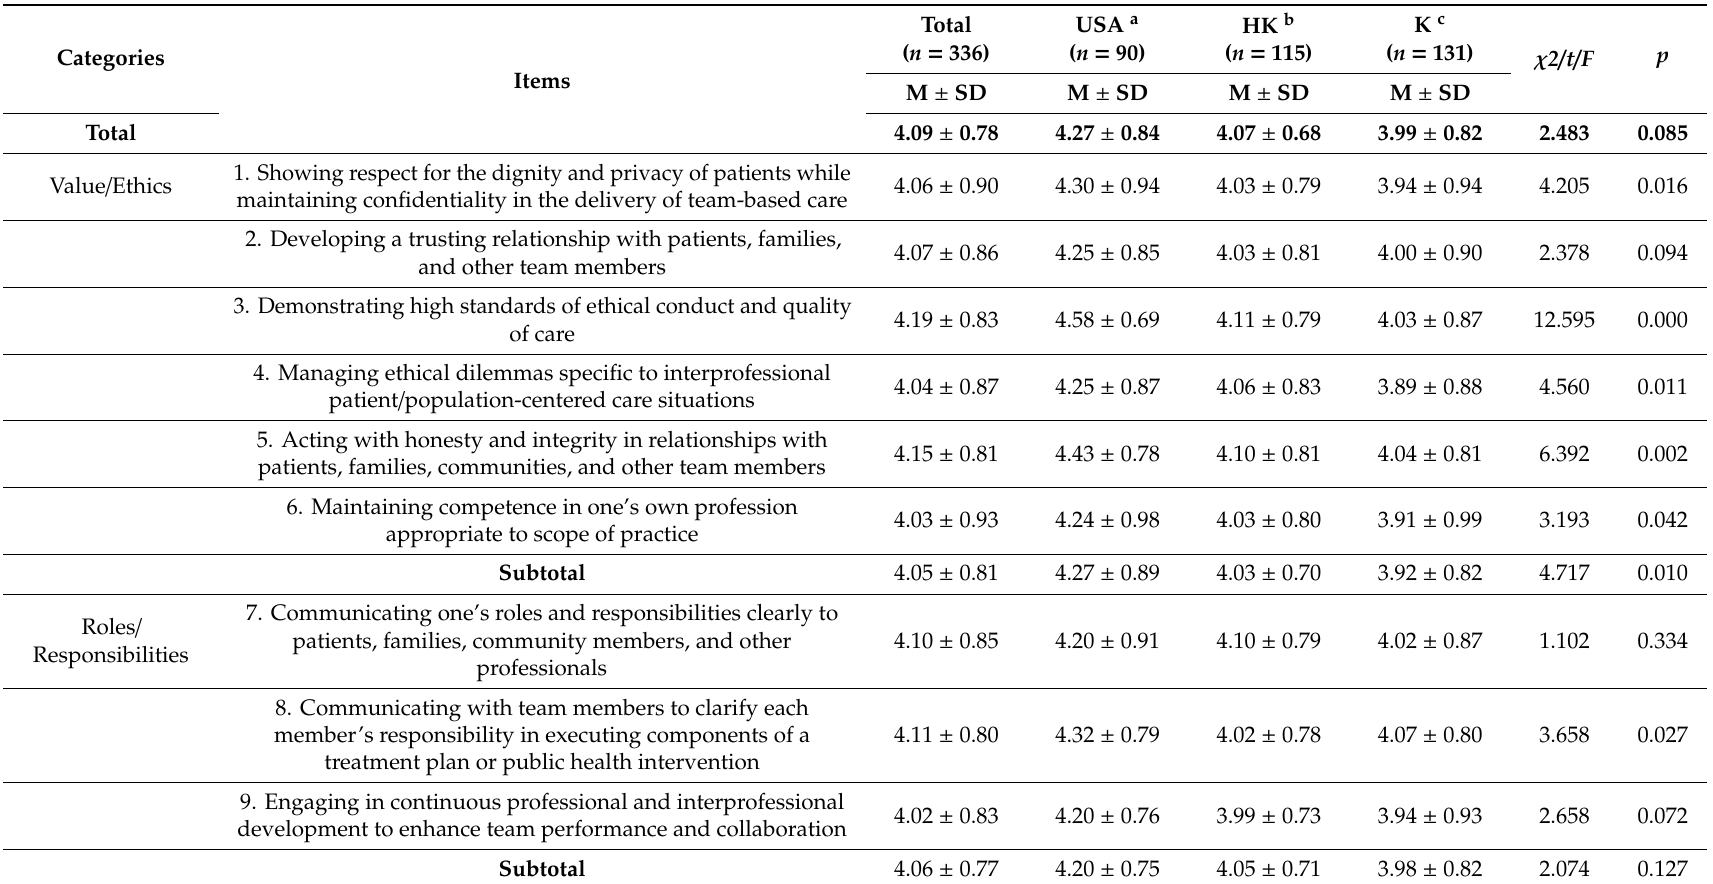
Table 4. Perceived benefits of